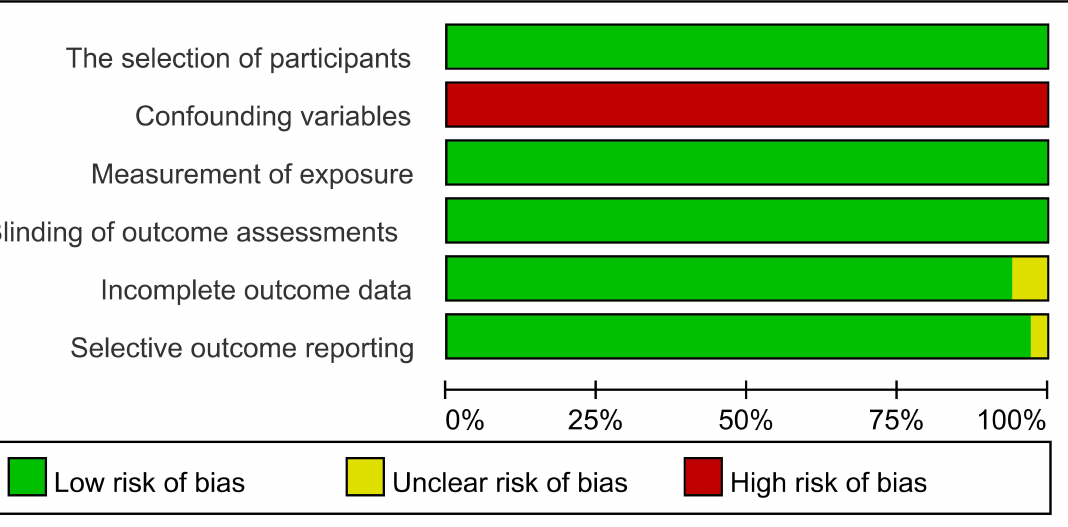
Figure 10. Graph of the Risk of Bias Assessment tool for Non-randomized Studies